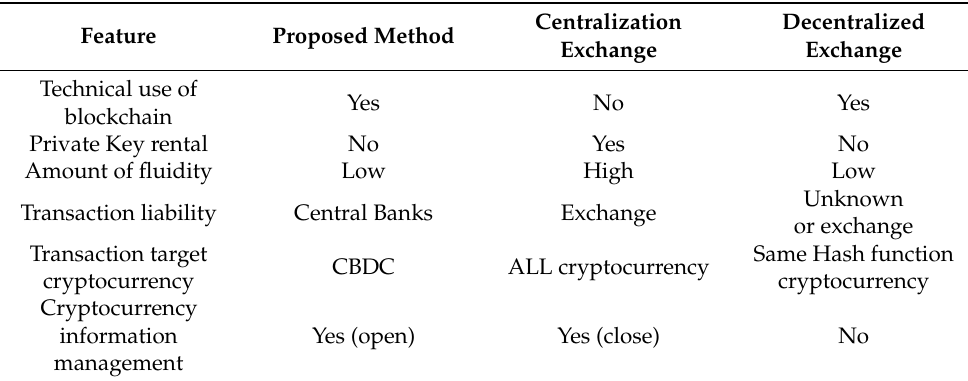
Table 2. Comparison of proposed methods and related